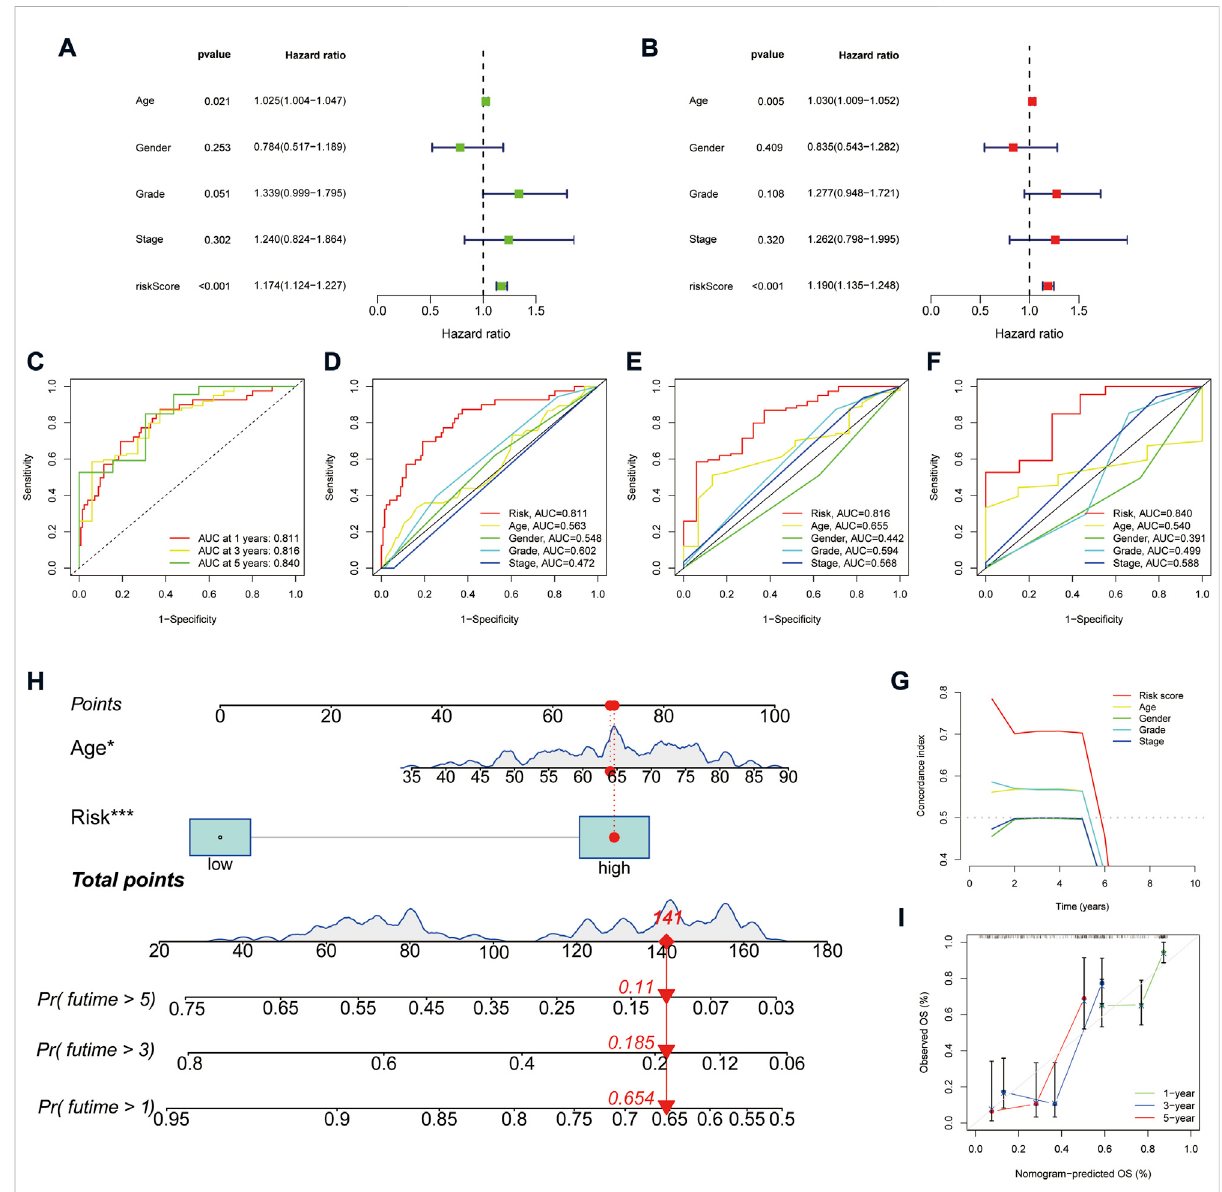
FIGURE 5 Assessment of the predictive signature. (A,B) Forest plot for univariate Cox (A) and multivariate Cox regression analysis (B) . (C) ROC curves of 1, 3, and 5 years survival for the predictive signature. (D – F) Comparison of the prediction accuracy of the risk model with age, gender, grade, and TNM stage at 1, 3, and 5 years. (G) The consistency index analysis curve. (H) Nomogram for predicting the 1, 3, and 5 years survival of patients with HCC. (I) The calibration curves for 1, 3, and 5 years